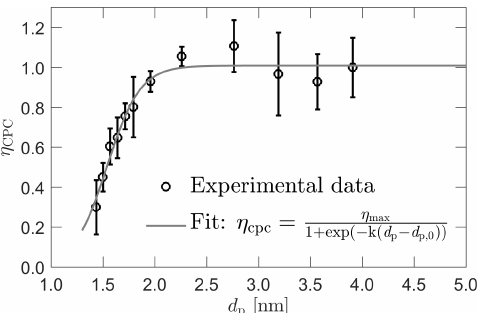
Figure 6. Detection efficiency of the two-stage CPC as a function of d p , the mobility-equivalent particle diameter. The efficiency is corrected for the dilution due to the vapor flow. The size-dependent detection efficiency is fitted to a logistic function with fitting pa- rameters η max = 1 . 01, k = 6 . 30nm − 1 , and d p , 0 = 1 . 54nm. The fit is used to approximate the CPC detection efficiency, η cpc , in the data inversion.